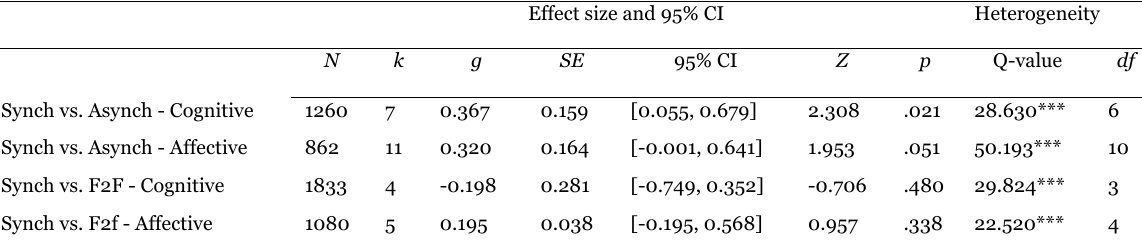
Effect size and 95%